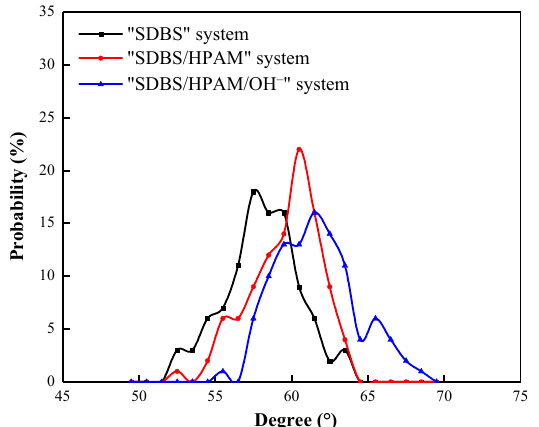
Figure 5. Radial distribution function of N 2 molecules around water molecules of liquid films in different foam systems.